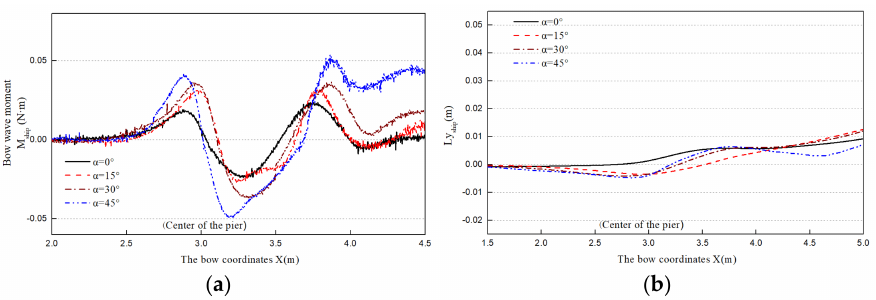
Figure 31. Schematic of the bow roll moment and center of gravity position of a ship passing through a round-ended pier with different flow angles of attack: ( a ) Bow roll moment; ( b ) Center of gravity